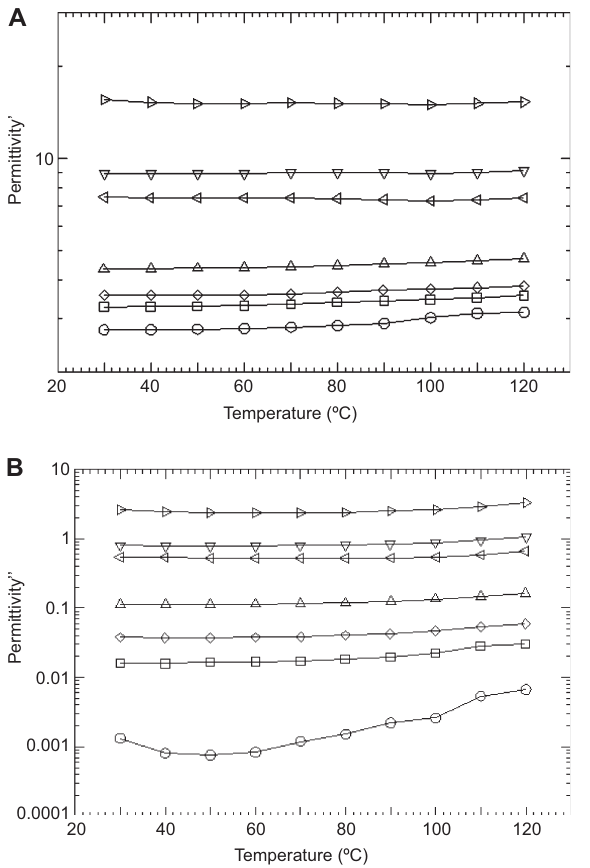
Figure 8 Loss tangent ( Loss Tg ) for PS/GTR at 30 ° C (A) and 50 Hz (B) in relation to temperature and frequency, respectively: ○ PS; □ PS+5% GTR; ◊ PS+10% GTR;  PS+20% GTR;  PS+40% GTR;  PS+50% GTR;  PS+70%